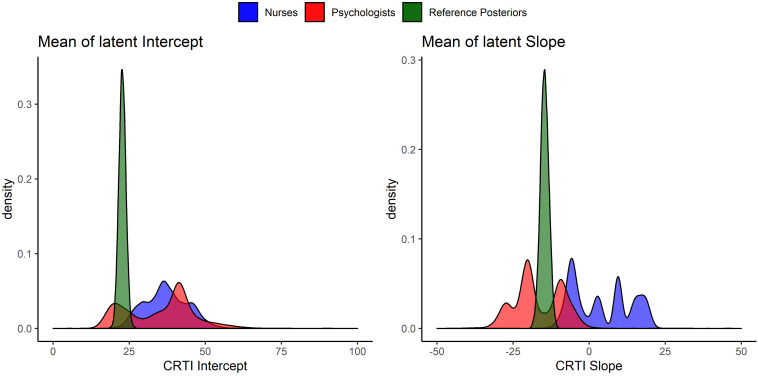
Visual representation of the reference posterior densities for the group mean of latent intercept and slope with the group expert priors for the parameters. The reference posteriors are approximately distributed, CRTIIntercept∼N(22.7,1.3), and CRTISlope∼N(−14.6,1.9).